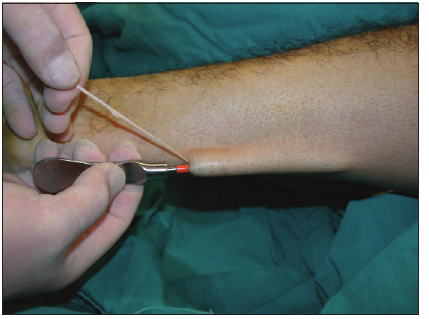
Figure 6. When the lateral branch was encountered, it was divided through supplement mini skin incision to complete the